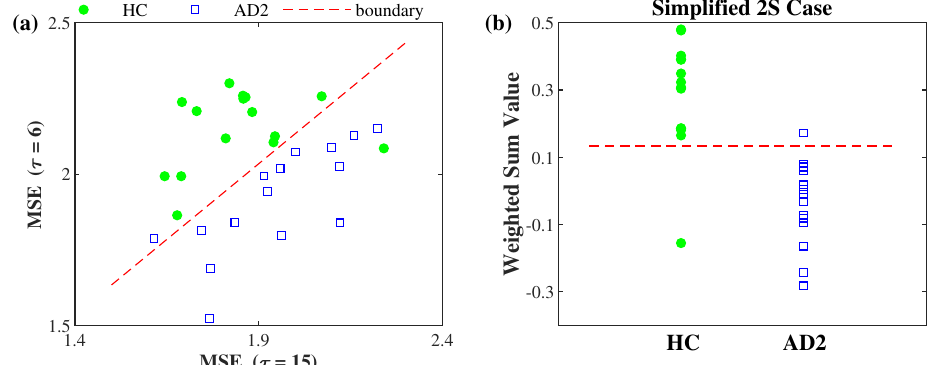
Figure 3. The differentiating result with the same data as in Figure 1 using simplified weighted sum model as MSE ( τ = 6) − MSE ( τ = 15). The F1 score is 0.933. ( a ) The MSE ( τ = 6) vs. the MSE ( τ = 15) of the 30 EEG signals recorded from the T4 electrode. The 15 circle and 15 square symbols are from 15 healthy subjects and 15 patients with moderate to severe AD, respectively. The red dashed line is the differentiating boundary. ( b ) The weighted sum values of the 30 signals. The red dashed line is the differentiating boundary with threshold value